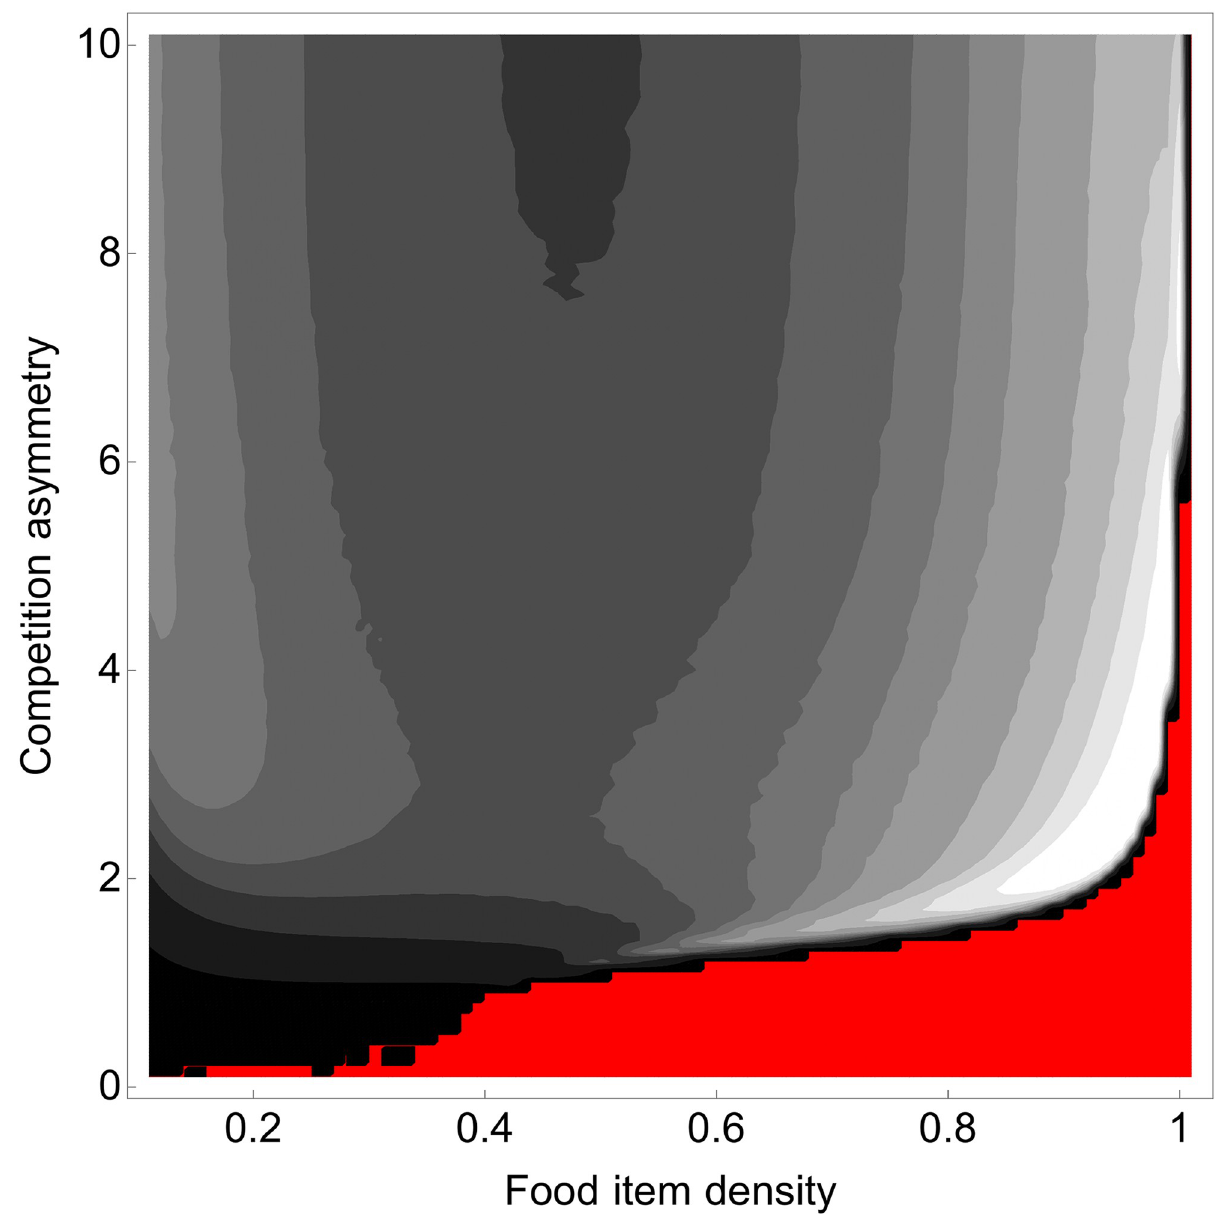
Fig 8. Values for coexistence criterion according to food item density and the degree of competition asymmetry. The red area is where coexistence criterion is zero (no possible coexistence for two different foraging area). The lighter areas indicate where criterion values are higher (i.e. the areas of possible coexistence for two different foraging strategies are larger). Here, b = 0.1, μ =